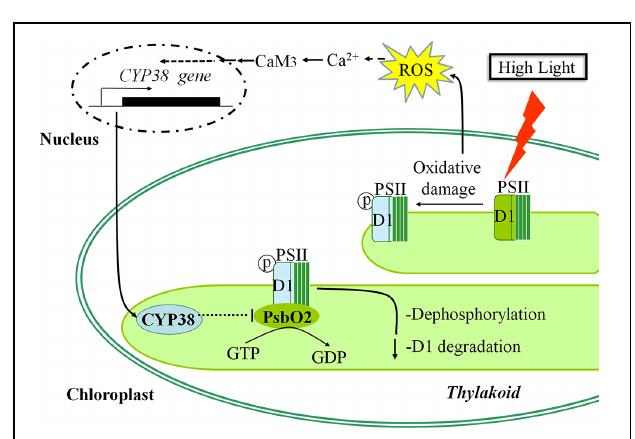
FIGURE 8 | Model showing the possible signaling pathway for CYP38-induced protection of photosystem II in Arabidopsis under high light stress